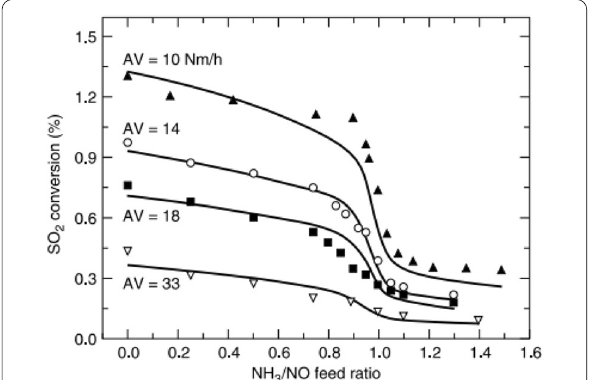
Fig. 13 Effect of NH 3 /NOx ratio and AV to SO 2 ‑SO 3 conversion